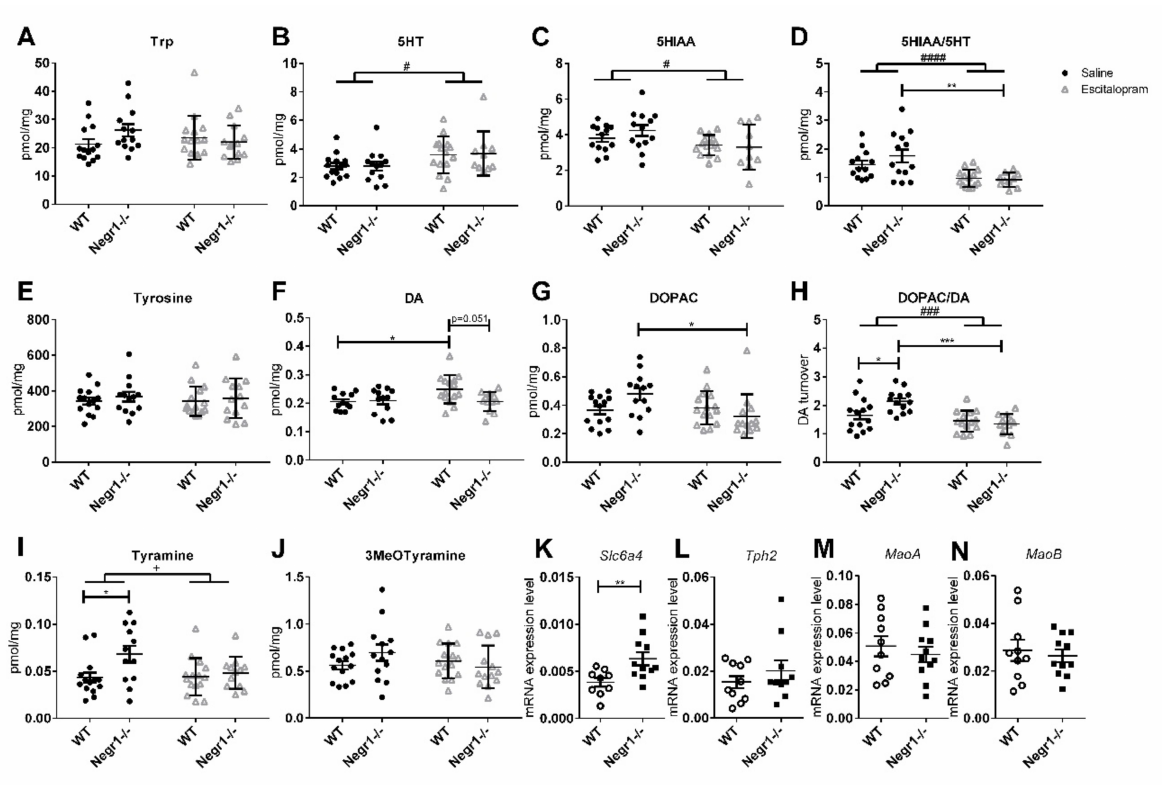
Figure 8. Effect of chronic escitalopram on the level of monoamines and their metabolites in the raphe nuclei. Batch II mice ( A – J ) and batch III mice ( K – N ). Levels of ( A ) tryptophan (Trp), ( B ) serotonin (5-HT), ( C ) 5-Hydroxyindoleacetic acid (5-HIAA), ( D ) serotonin turnover (5-HIAA/5- HT), ( E ) tyrosine, ( F ) dopamine (DA), ( G ) 3,4-Dihydroxyphenylacetic acid (DOPAC), ( H ) dopamine turnover (DOPAC/DA), ( I ) tyramine and ( J ) 3MeOTyramine in raphe. The mRNA expression level of ( K ) serotonin transporter ( Slc6a4 ), ( L ) tryptophan hydroxylase 2 ( Tph2 ), ( M ) monoamine oxidase A ( MaoA ), and ( N ) monoamine oxidase B ( MaoB ). Data represent mean ± SEM, # p < 0.05, ### p < 0.001, #### p < 0.0001—treatment effect, + p < 0.05—genotype effect, * p < 0.05, ** p < 0.01, *** p <